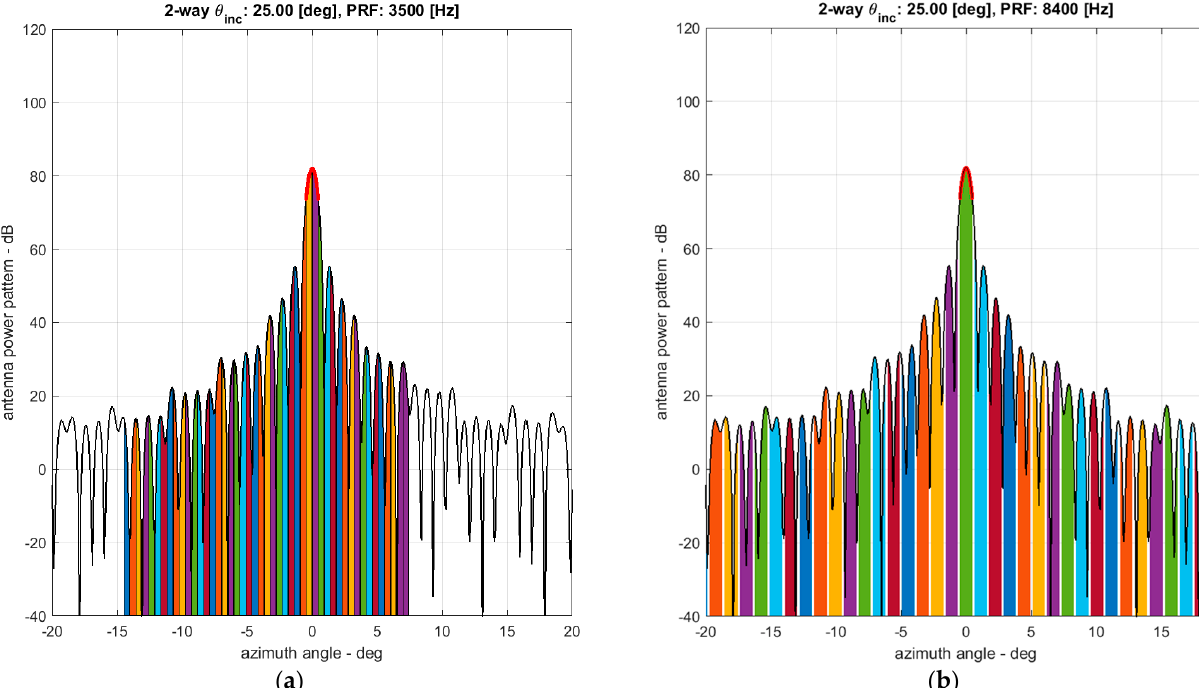
Figure 30. Azimuth ambiguities at PRFs of ( a ) 3500 and ( b ) 8400 Hz. Each color bar corresponds to the azimuth ambiguity at a specific azimuth angle. No overlap between azimuth ambiguities is observed for a PRF of 8400 Hz, which is larger than the Doppler bandwidth.